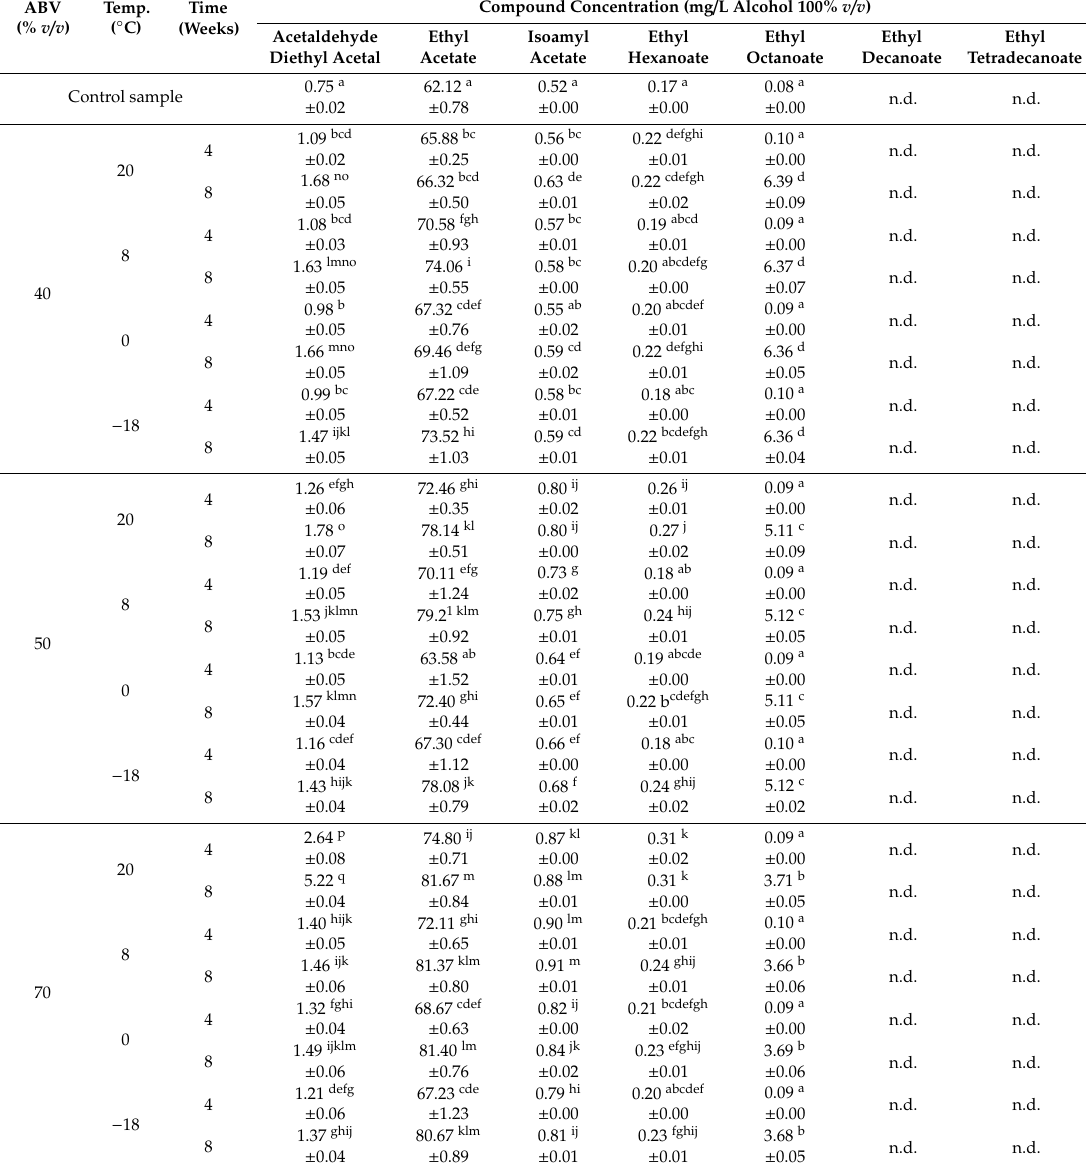
Table 4. Changes in acetals and esters in rye distillate samples during storage at di ff erent temperatures. ABV Temp. (% v / v ) ( ◦ C) Control sample